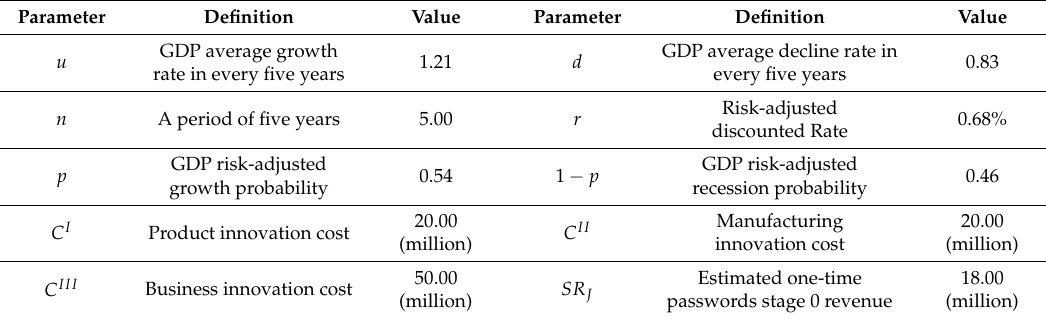
Table 1. Parameter assumptions.